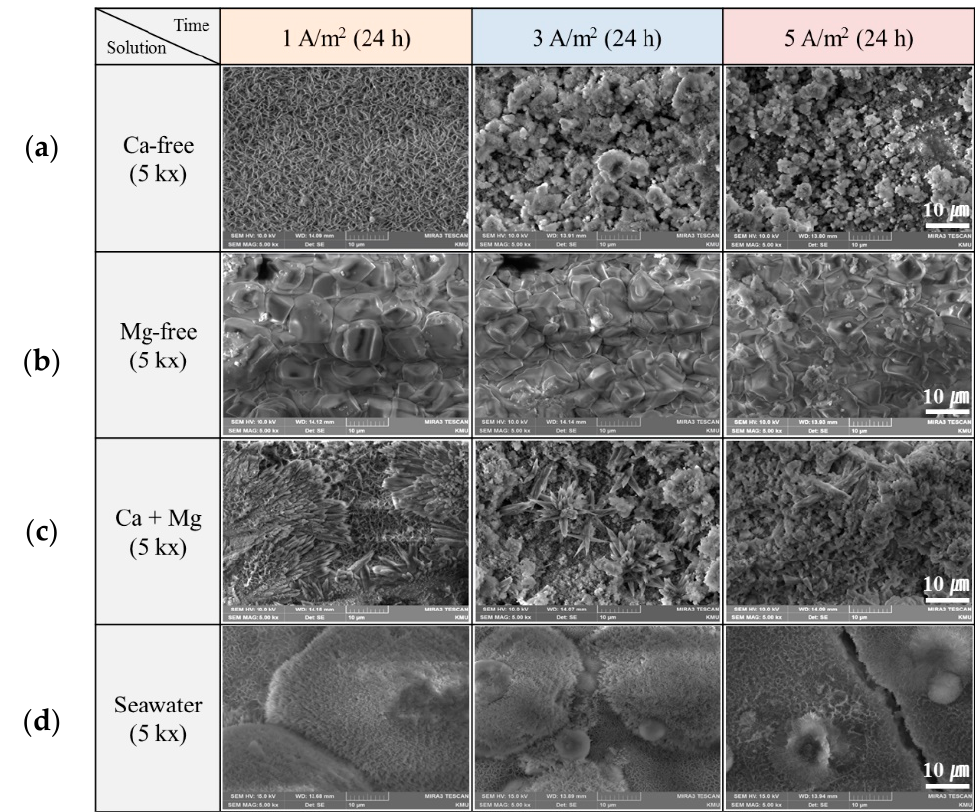
Figure 6. Morphology of the calcareous deposit films after 24 h in each solution ( a ) Ca-free, ( b ) Mg-free, ( c ) Ca + Mg, ( d ) natural seawater.